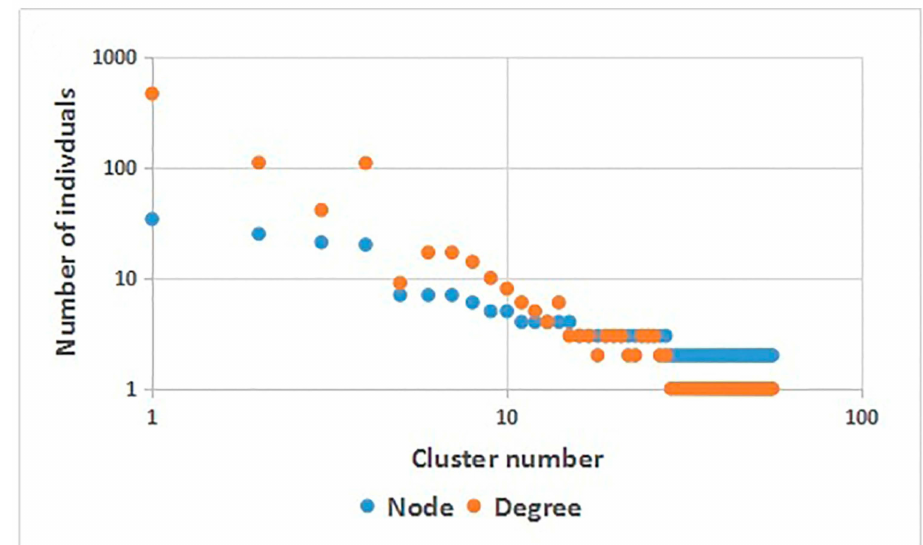
Figure 3. Molecular network parameters. Int. J. Environ. Res. Public Health 2023 , 20 , x